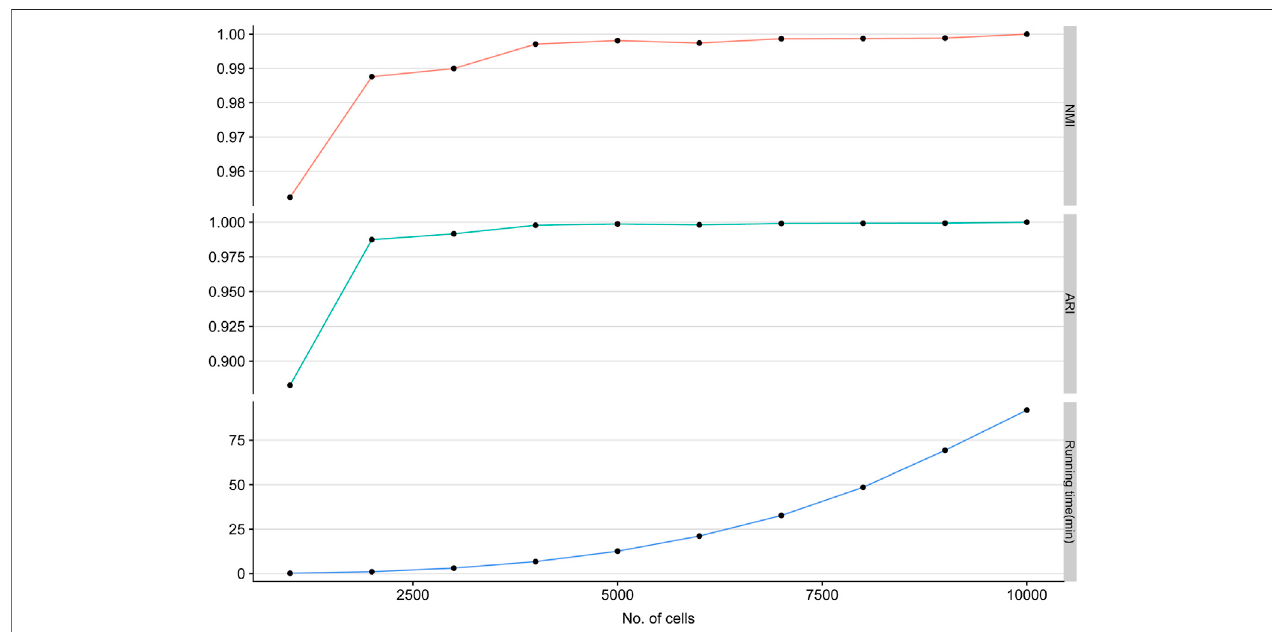
FIGURE3| ApplyingLSSDonvarious samplesizesofsimulatedcells. LSSDapplied ondifferentsamplesizesindicates thehighstability ofclusteringperformance measured by NMI, ARI, and running time.